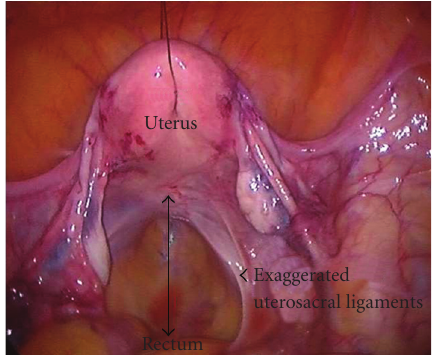
Figure 4: Hitching up the uterus improves the stability of the uterus. The uterosacral ligaments are stretched and this eases the posterior